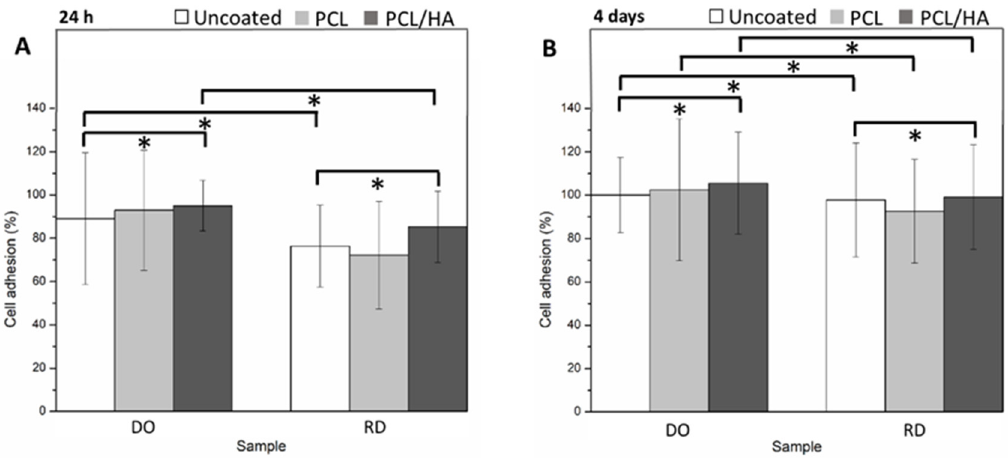
Figure 10. Cell viability at ( A ) 24 h and ( B ) 4 days on DO and RD uncoated, coated with PCL and with PCL/HA— p < 0.05 *.